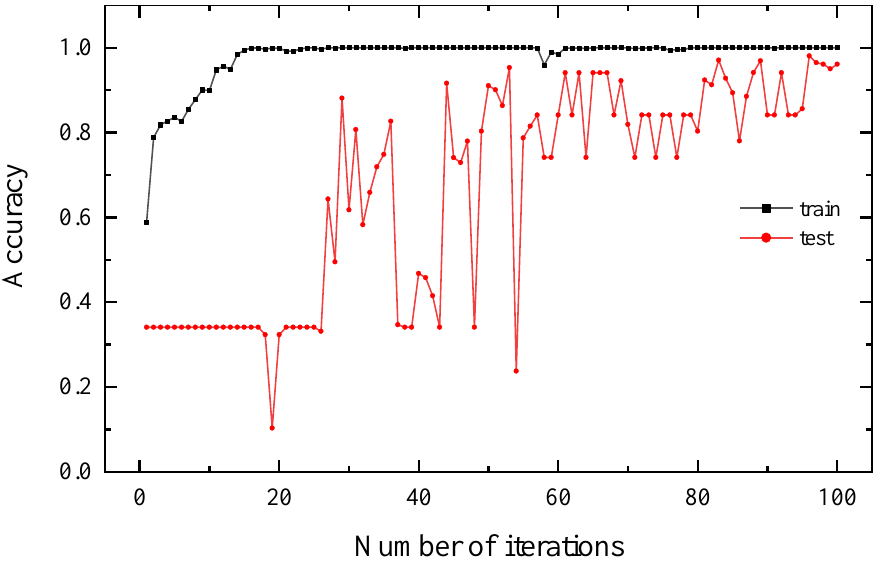
Figure 13. The curve of iterative convergence. The accuracy on the training set is shown by the black line, while the accuracy on the test set is represented by the red line. Table 5. Validation set contains label table.